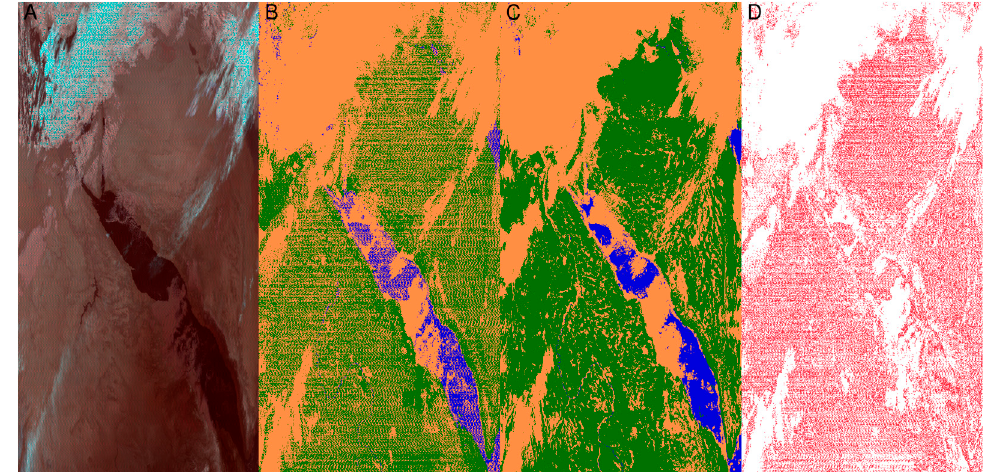
Figure 3. Channel 3b noise effects in a portion of an AVHRR GAC orbit over Egypt and the Arabian peninsula (Test Area 1 in Figure 1) from 1 January 1983 (near 00 UTC). ( A ) colour composite image based on brightness temperatures of the three AVHRR infrared channels 3b, 4 and 5 at 3.7, 11 and 12 microns, respectively; ( B ) cloud mask product for the same image (using the same colour table as in Figure 2B,C); ( C ) cloud mask product after using the channel 3b noise filter; ( D ) difference plot where red indicates either removal or adding of clouds.